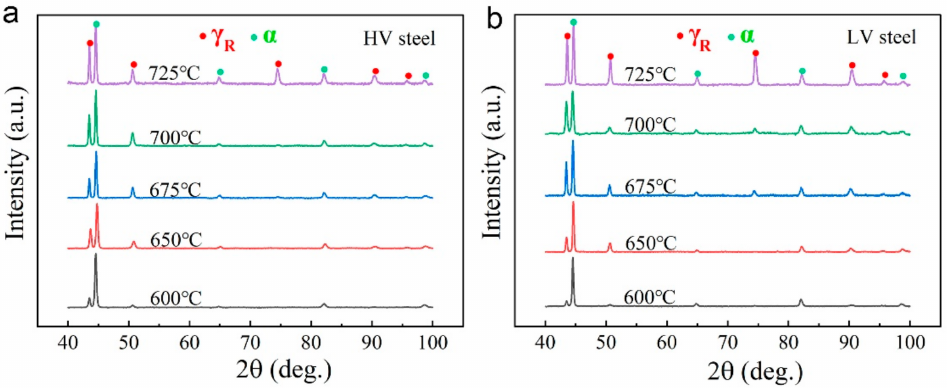
Figure 5. XRD patterns of samples annealed at different temperatures: ( a ) HV steels; ( b ) LV steels. The diffraction peaks corresponding to the red dots refer to austenite, while green dots refer to